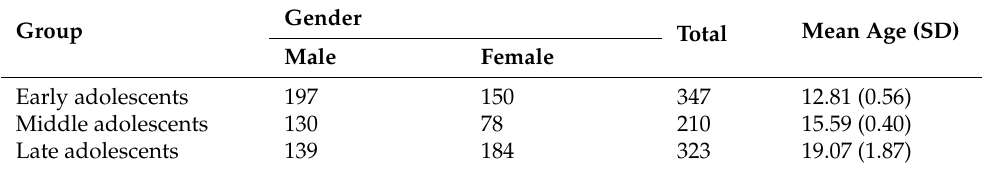
Table 1. Participant Demographic Information.